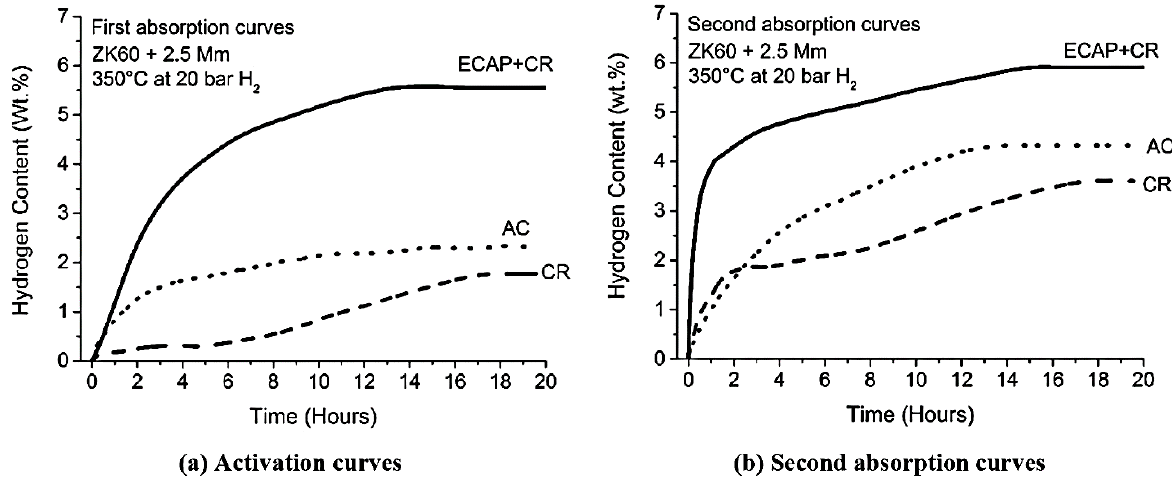
Figure 2. Kinetic curves of ZK60 with Mm ( a ) activation; ( b ) Second absorption. Reprinted with permission from Soyama J et al. (2016) Copyright 2016, Hydrogen Energy Publications.